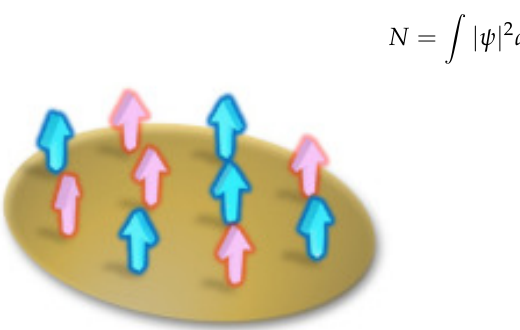
Figure 1. Schematic diagram of the 2D binary dipolar system plane, with all the dipoles oriented perpendicular to the 2D plane. The two types of arrows with different colors (pink and blue) represent the two components of dipolar atoms in the